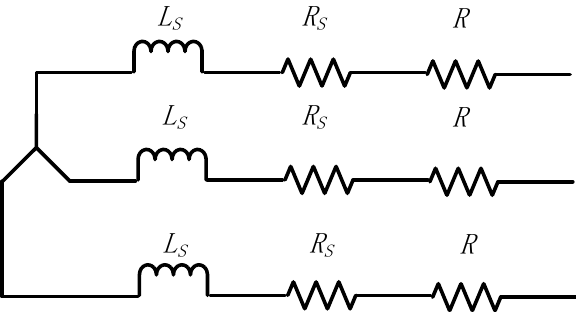
the interference of the noise signal, the collected current signal is greatly distorted. At this Figure 12. Three-phase winding fault injection. Figure 12. Three-phase winding fault injection.